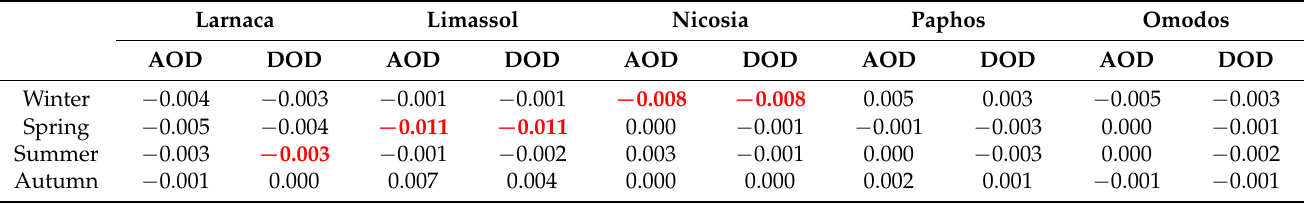
Table 3. Trends (absolute change per year) of the seasonal AOD and DOD. Values in red represent statistically significant